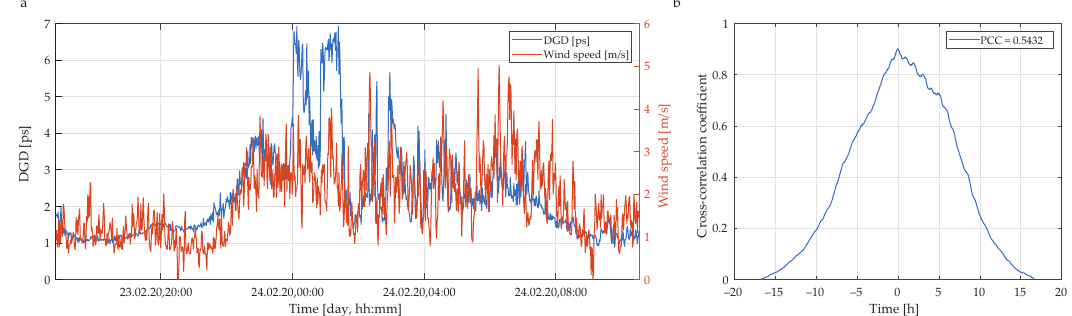
Figure 9. ( a ) Measured changes in average DGD and wind speed versus the measurement time. ( b ) Cross-correlation between measured DGD values and PCC. Strong wind condition (wind speed up to 20